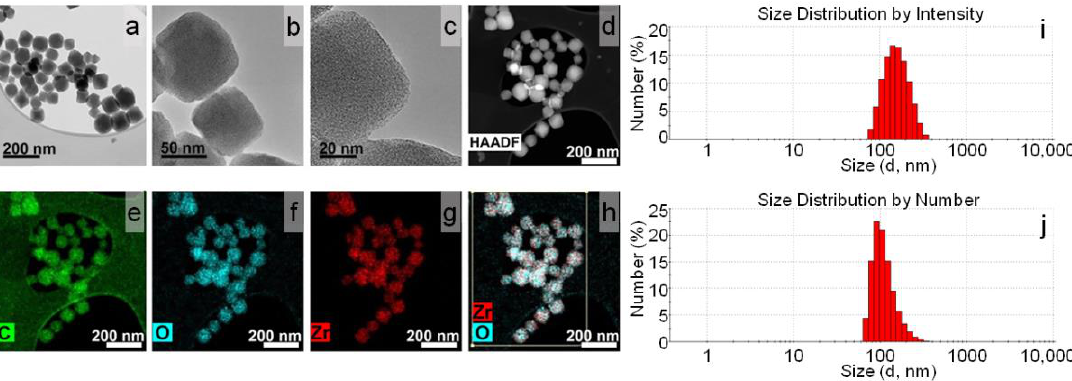
Figure 1. TEM/STEM images of intact UiO-66 MOFs and elemental mapping ( a – h ); DLS intensity ( i ); DLS number ( j ) distributions.